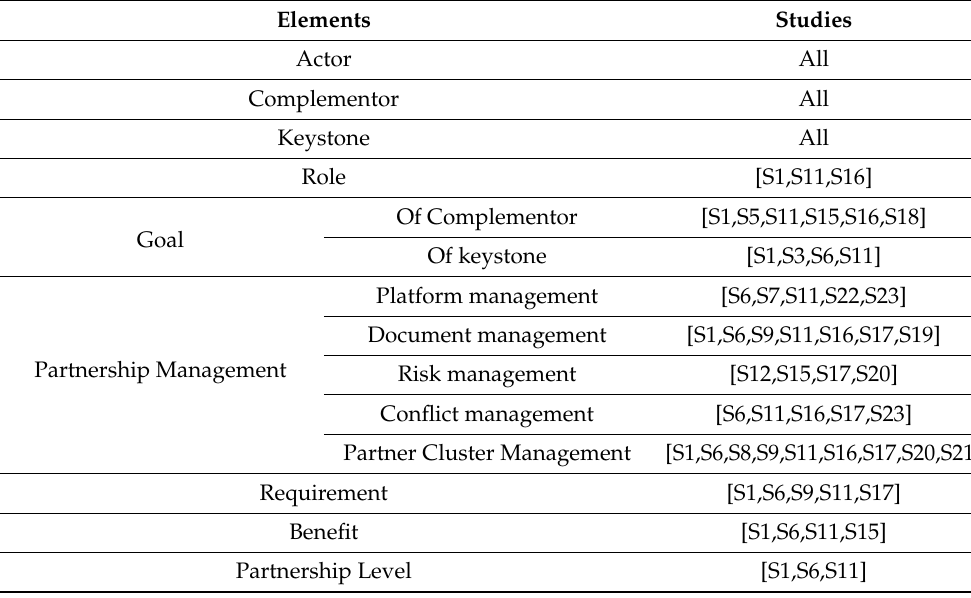
Table 3. Elements of the proposed partnership meta-model and primary studies of